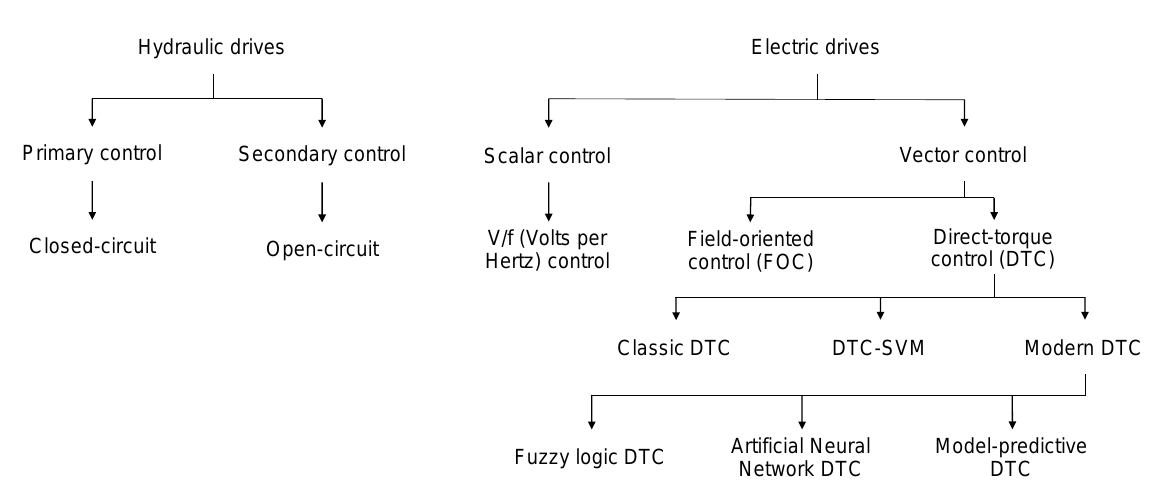
Figure 2: Classification of commonly used drives in offshore crane winches